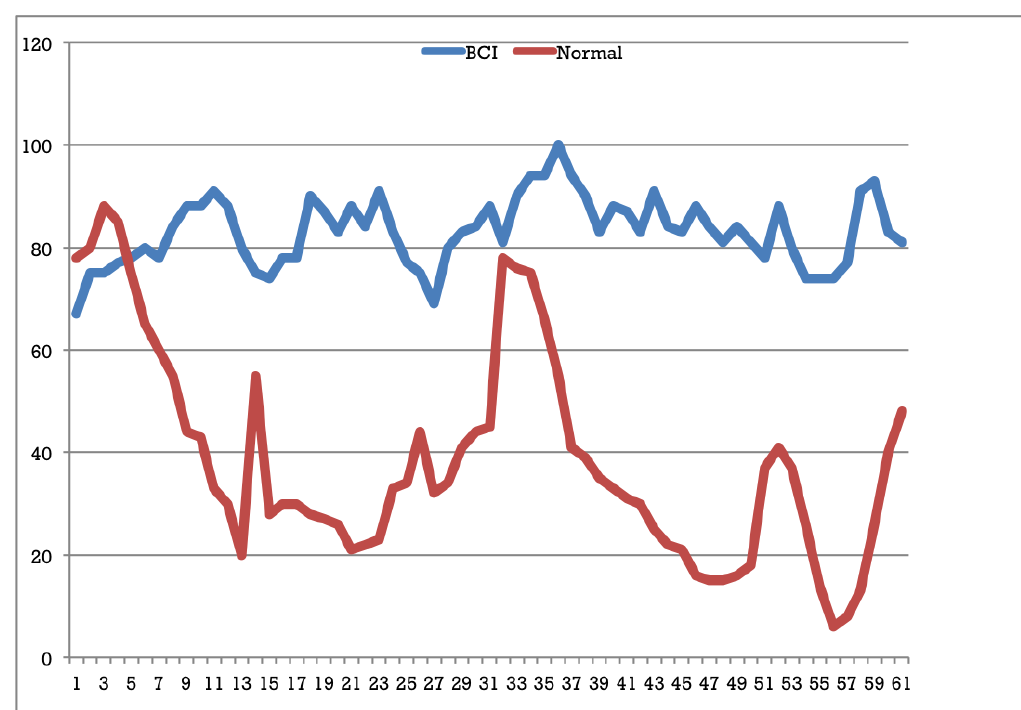
Figure 8: Attention level of User E during the in the first and last